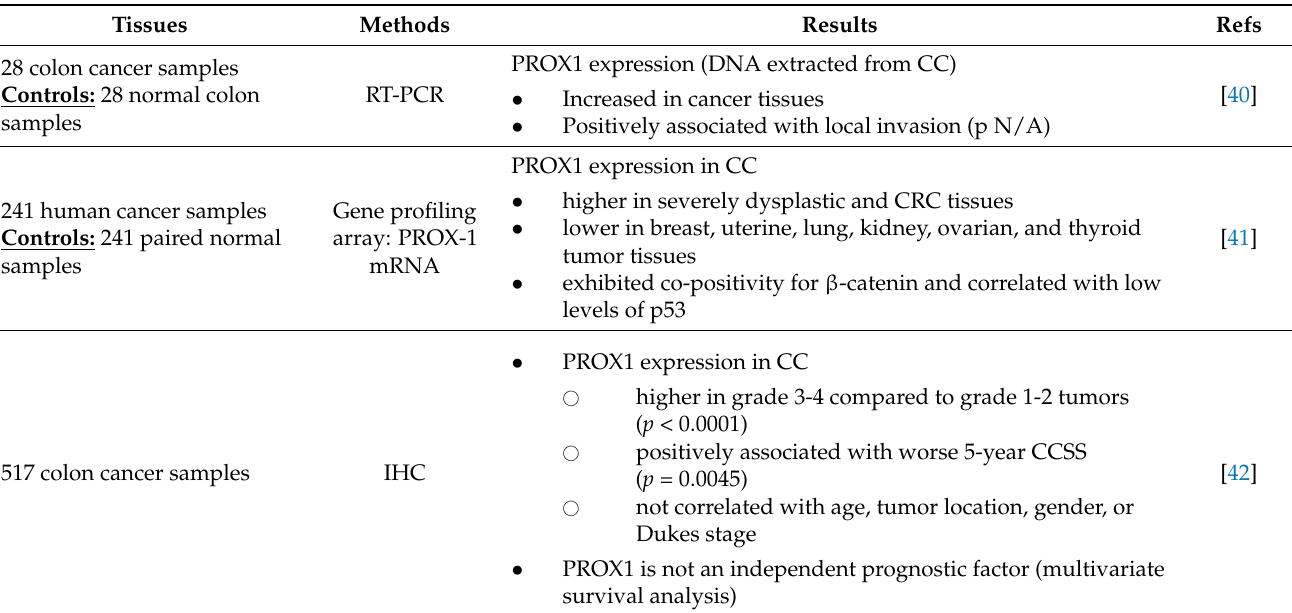
Table 3. Synopsis of studies evaluating the expression of PROX-1 in gastrointestinal and hepato- biliary-pancreatic